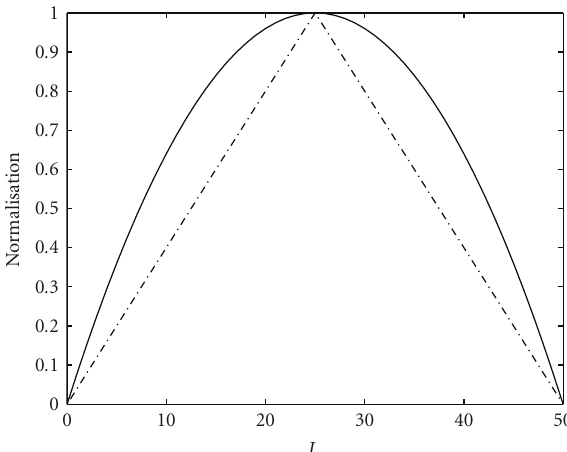
Figure 1: Normalization factors (scaled for convenience) as a function of L for the measure in [22] (solid) and based on the theory of angles between subspaces